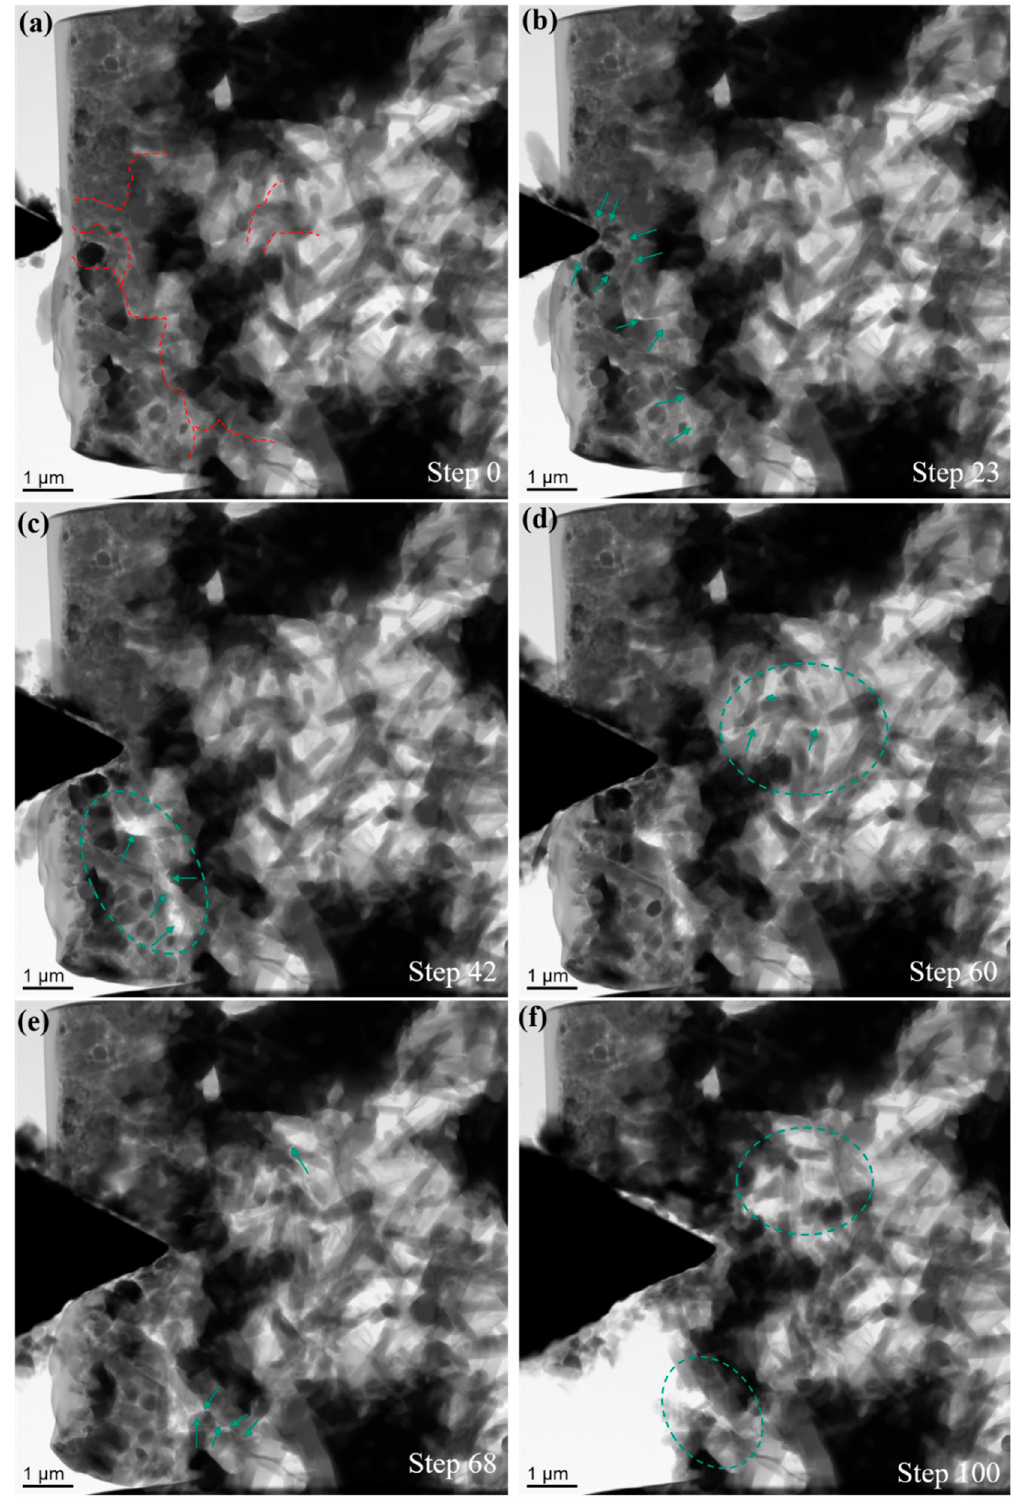
Figure 6. Representative TEM images selected from an in-situ experiment for a composite with 5 wt.% MLG. ( a ) Before the in-situ experiment, major cracks observed in the following experiment are highlighted by dashed lines; ( b – e ) selected TEM images during the in-situ experiment, crack propagation and fracture interfaces are highlighted by green arrows; ( f ) last TEM image recorded before retracting the indenter, fracture interfaces and rotated ceramic phases are highlighted by dashed ellipses.